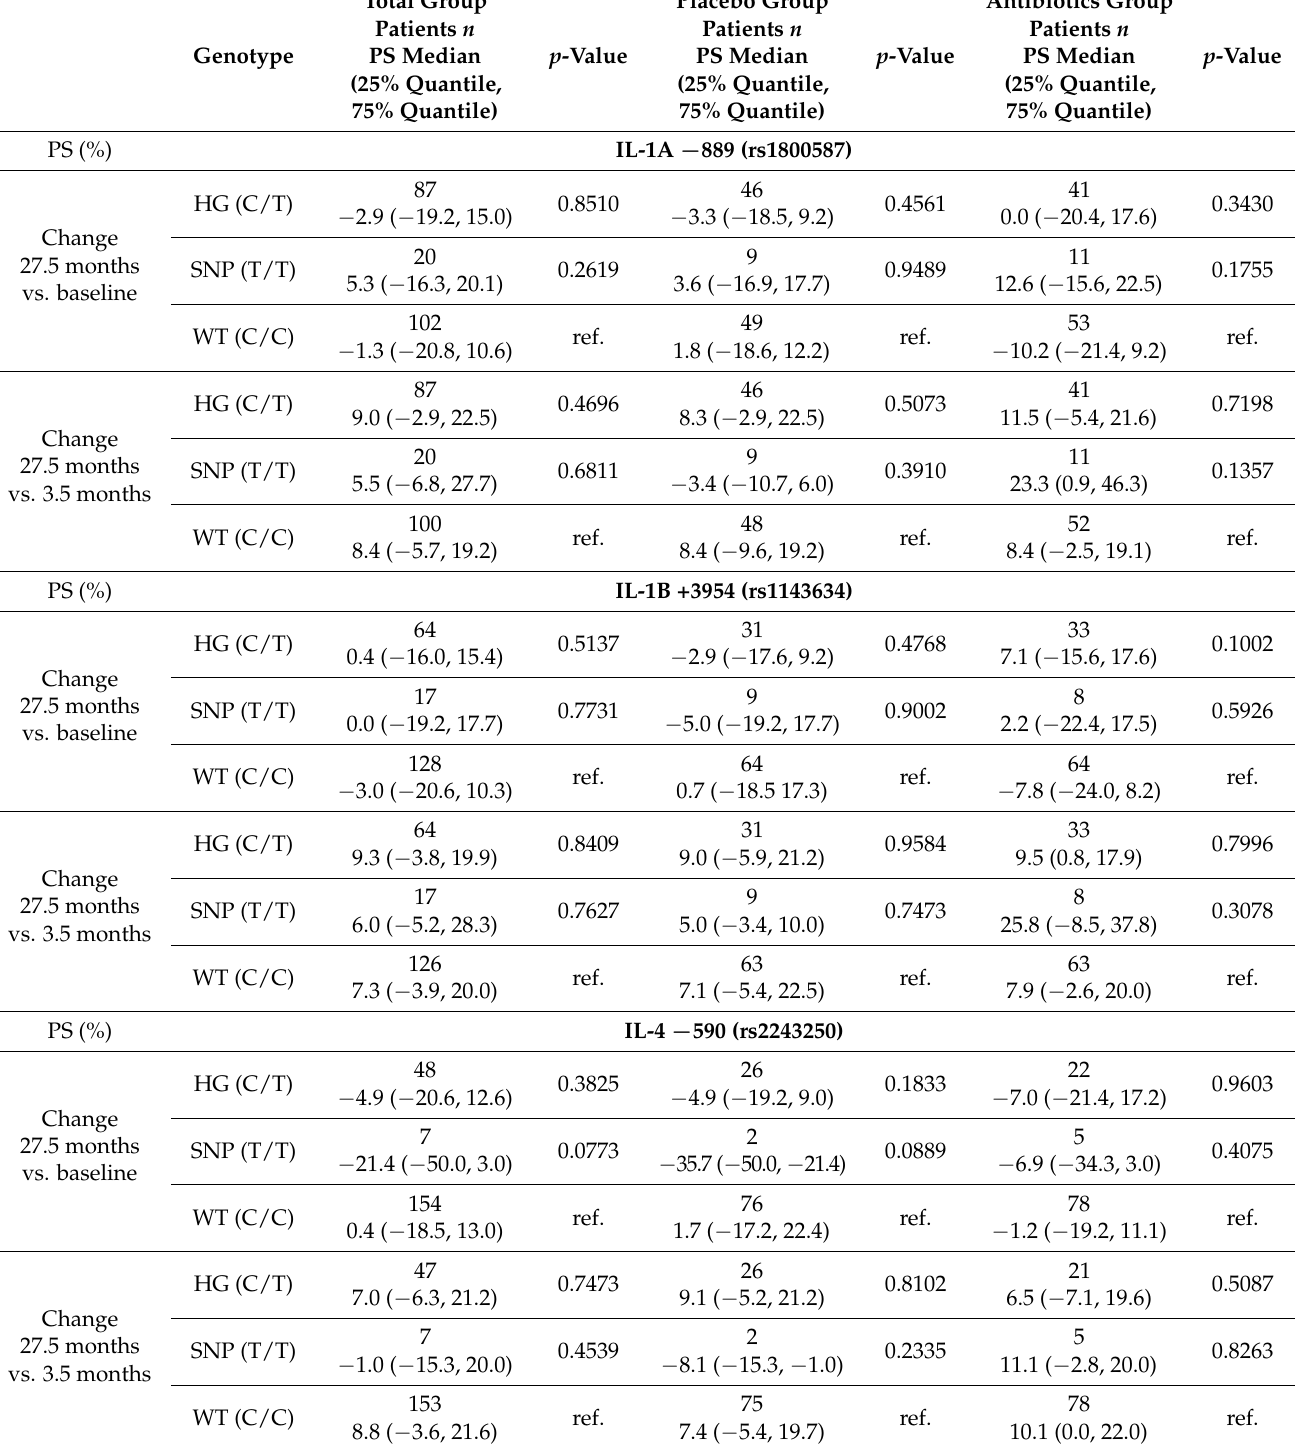
Table 5. Clinical measurements of the change of the percentage of sites with plaque per patient